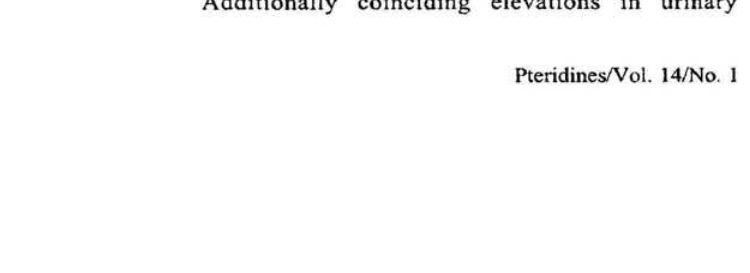
Figure 1 Urine neopterin concentrations (mmol neopterin/mol Creatinine) in a 5 year cid child moni- tored for l year every second